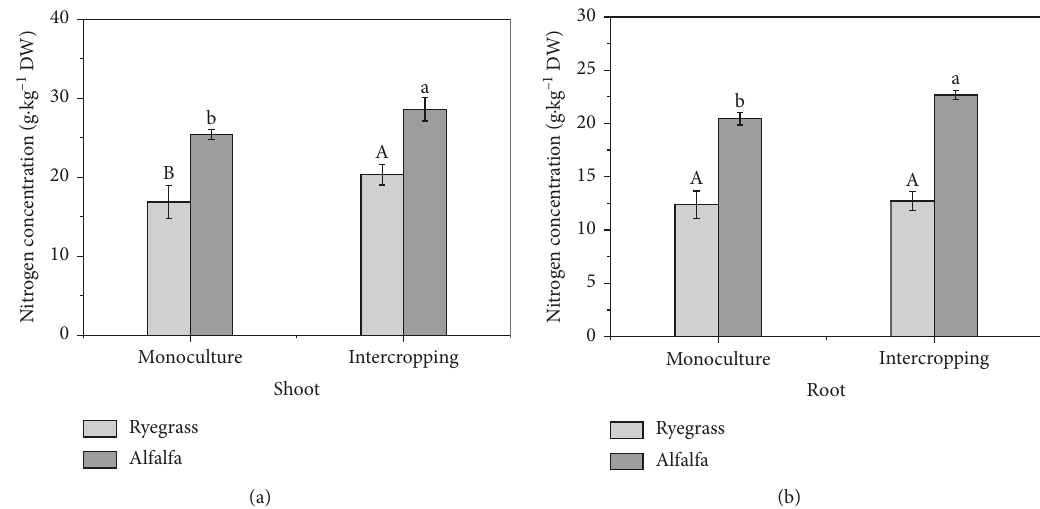
Figure 2: The nitrogen content in shoots (a) and roots (b) of ryegrass and alfalfa under monoculture and intercropping treatments. Bars are the standard error ( n � 3). Means followed by the same letter are not significantly different at ( p < 0 . 05).